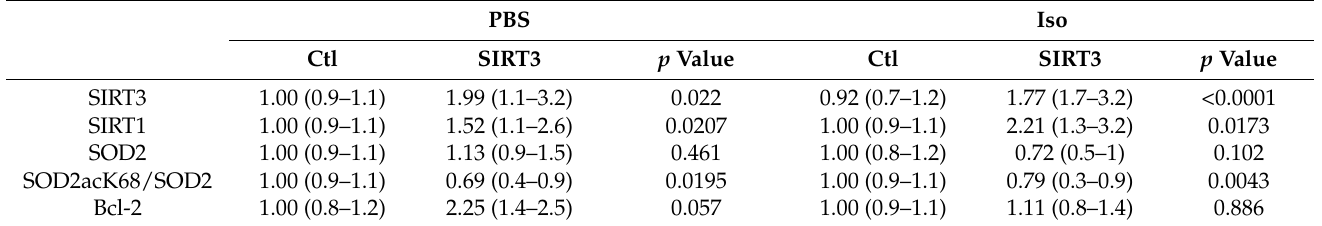
Figure 3. Effect of SIRT3 overexpression on SOD2 activation and mitochondrial oxidative stress in control and hypertrophied neonatal rat cardiomyocytes (NCMs). Control (PBS) or Iso-treated NCM were transfected with an empty vector (PCMV6) (gray box) or SIRT3 cDNA (3 µg, dark blue box) for 72 h. Quantification by Western blot of SIRT3 and SIRT1 expression ( a ) and SOD2acK68/SOD2 ratio and SOD2 expression ( b ) in Iso-treated NCM transfected with control or with SIRT3. Data were normalized on actin. ( c ) Mitochondrial superoxide anions production was detected after MitoSOX (red) and nuclei (blue) staining and quantified from 3 independent experiments and at least 168 cells. ( d ) Cell area was quantified from 3 independent experiments and at least 51 cells after alpha-actinin (red) and nucleus (blue) staining. Scale bar = 20 µm. Only significant p values are indicated from 3 independent experiments. Images were selected to represent the mean values of each condition. Table 2. Quantification of the effect of SIRT3 overexpression on sirtuins and SOD2 activation in control and hypertrophied neonatal rat cardiomyocytes (NCMs) by Western blot. PBS